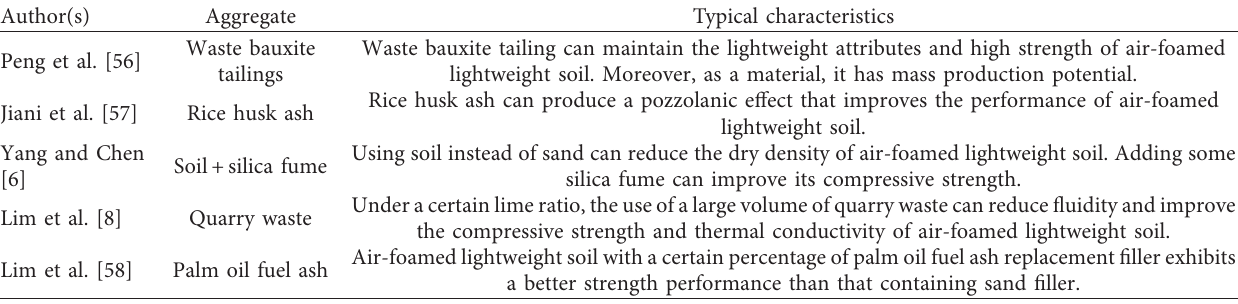
Table 1: Summary of the aggregates of air-foamed lightweight soil and their typical characteristics.